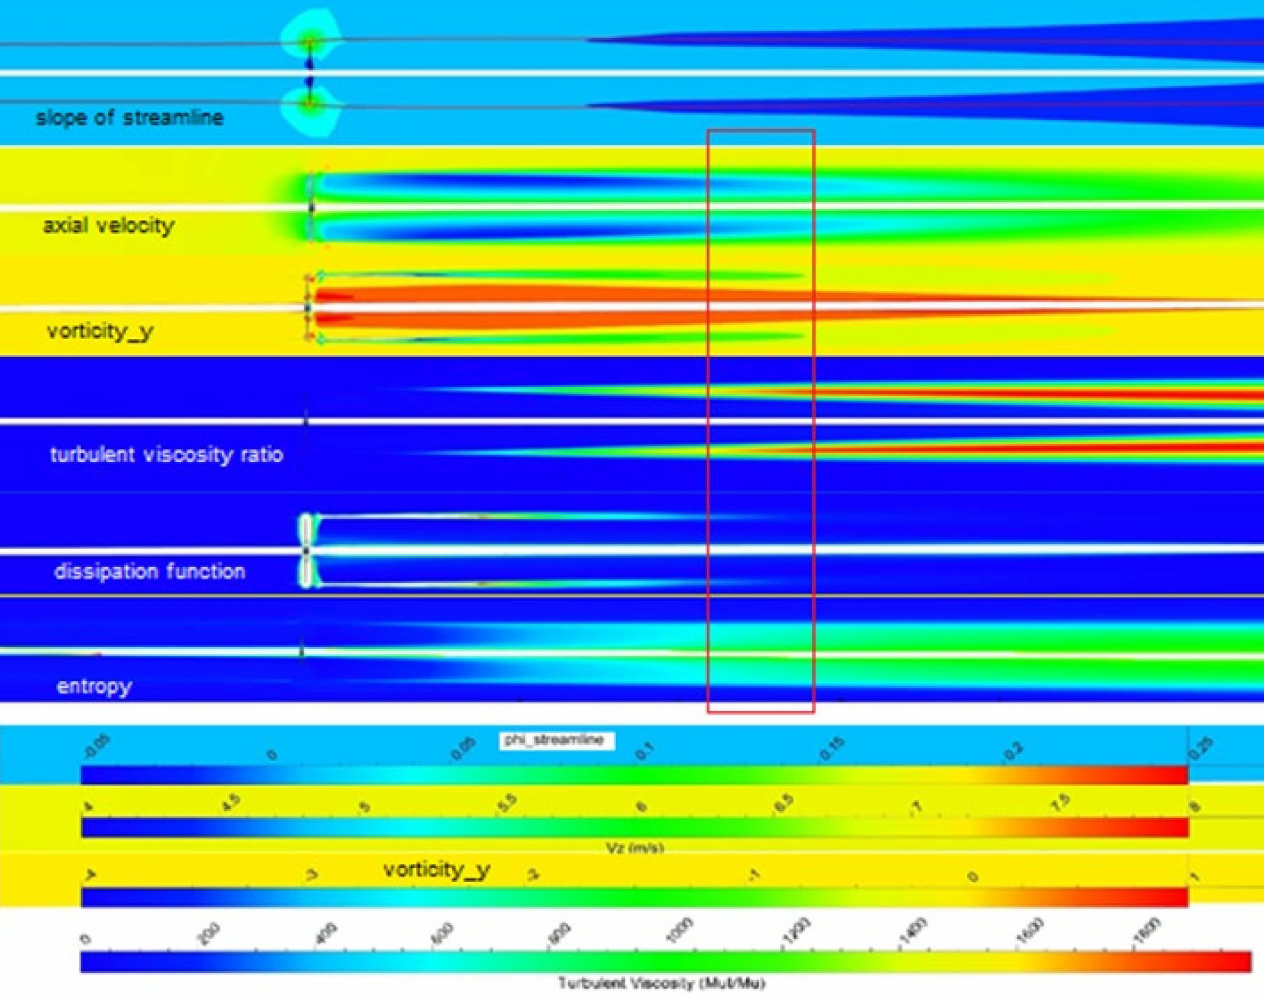
Figure 36. Several aerodynamic properties downstream of wind turbine rotor for